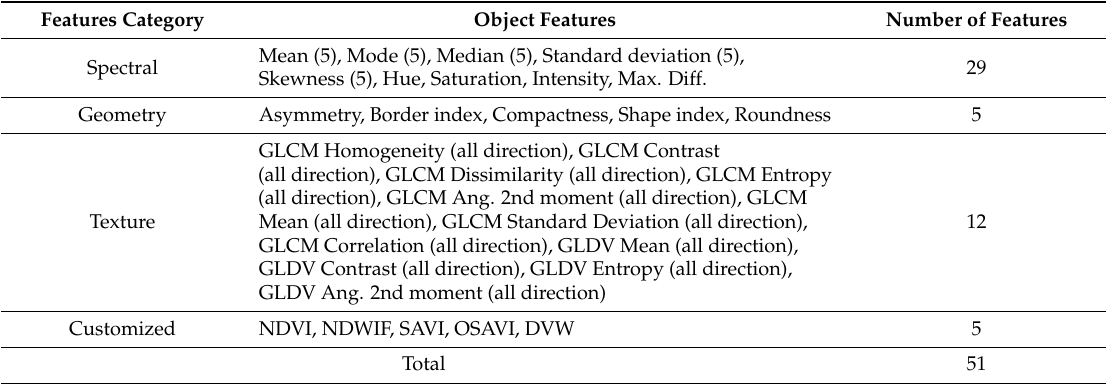
Table 1. Features used to identify image objects in this study.